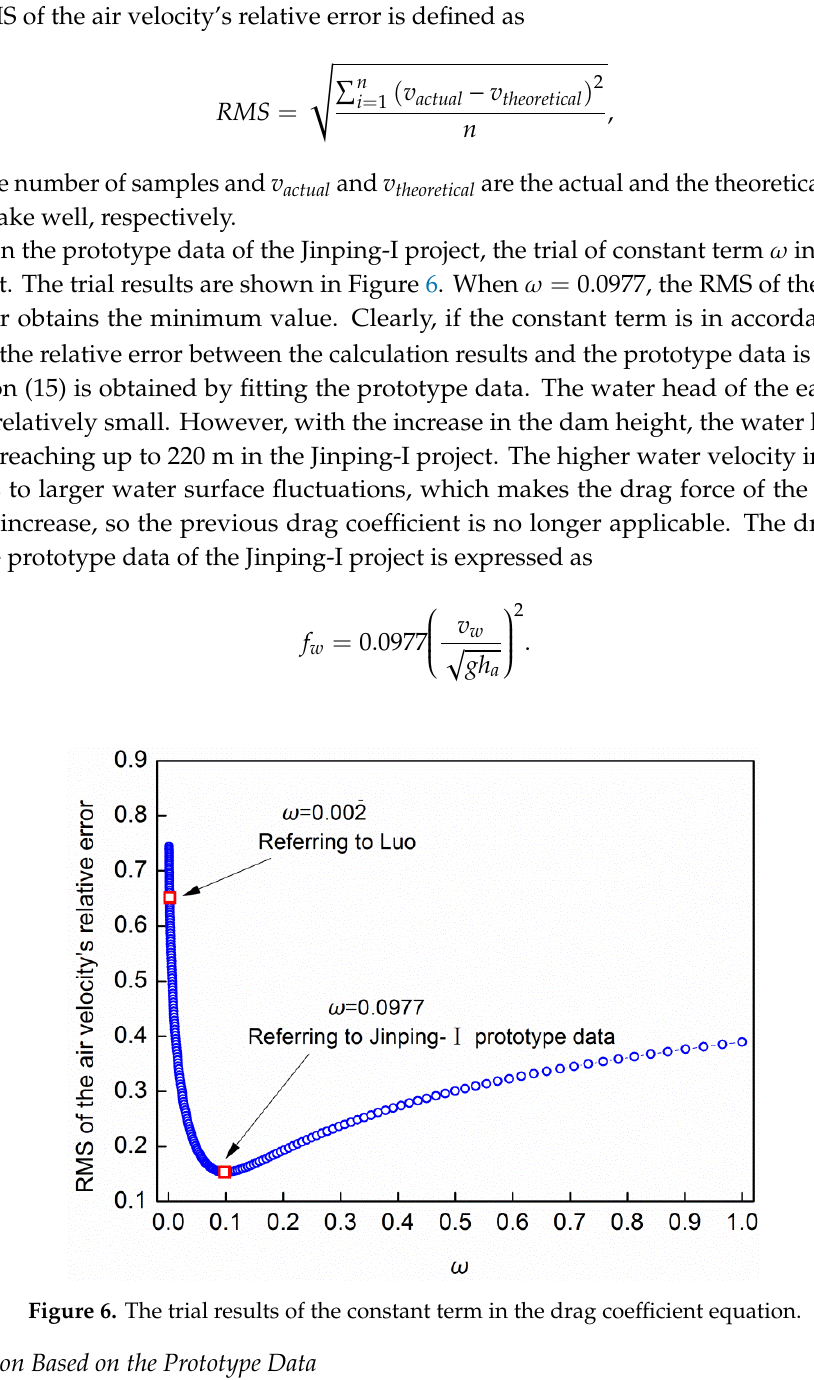
Figure 6. The trial results of the constant term in the drag coefficient equation.